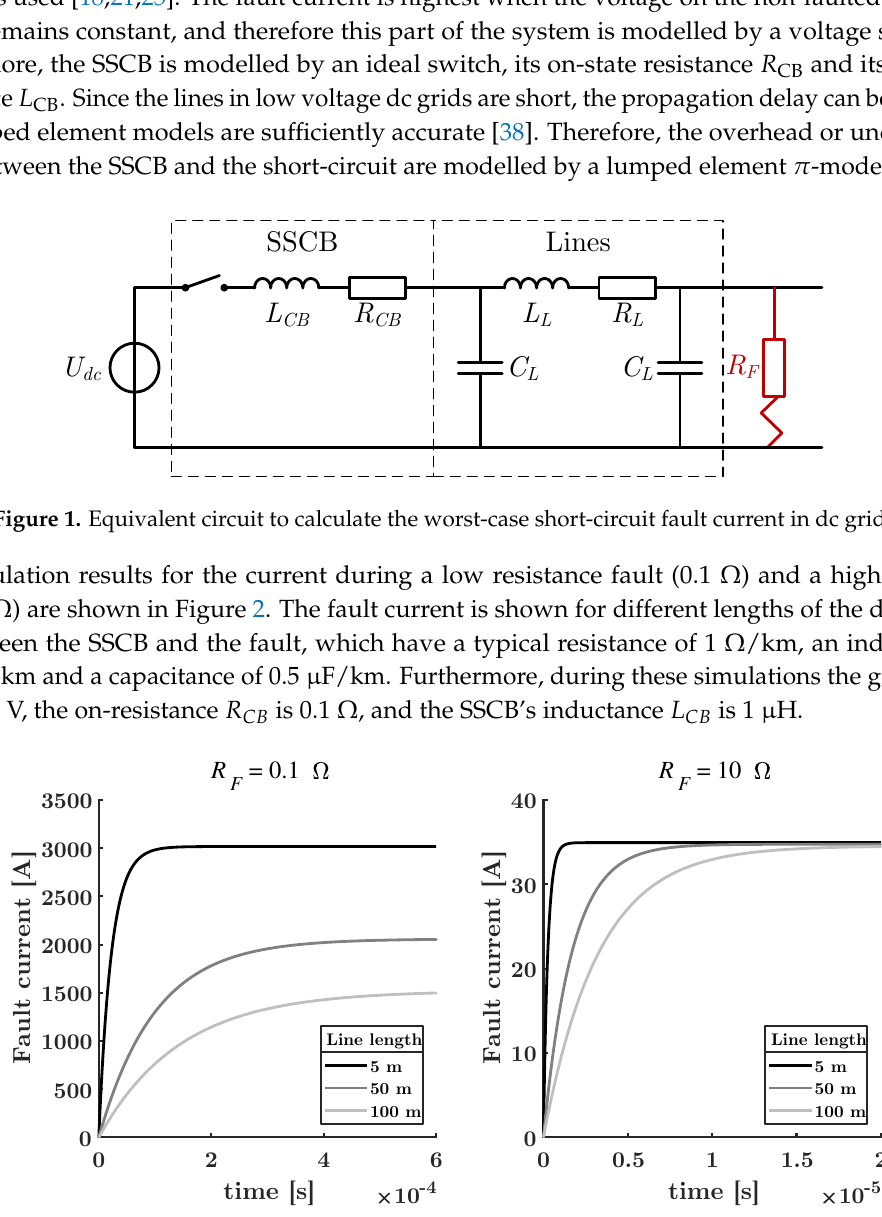
Figure 2. Simulation results for the fault current in the equivalent circuit of Figure 1 for different fault resistances and distribution line